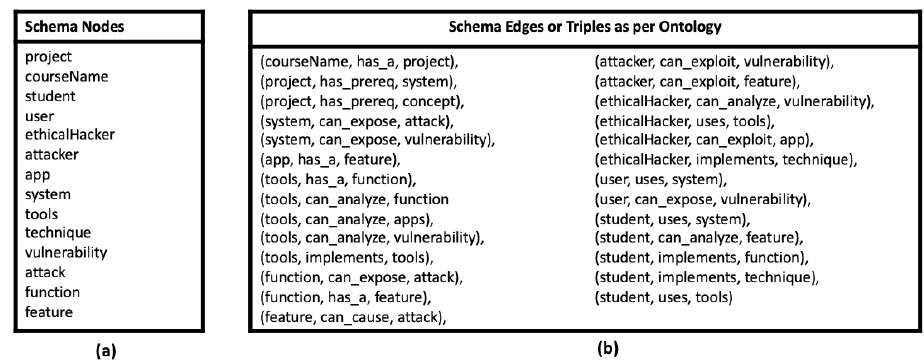
Figure 5. Cybersecurity education ontology schema. ( a ) The first figure represents the valid nodes in the schema ( b ) The second figure shows the schema edges or triples as per the ontology. Any new DDL operation such as insertion, cloning, merging or the removal of nodes on graph is schema-aware and should follow these tuples as per schema validation